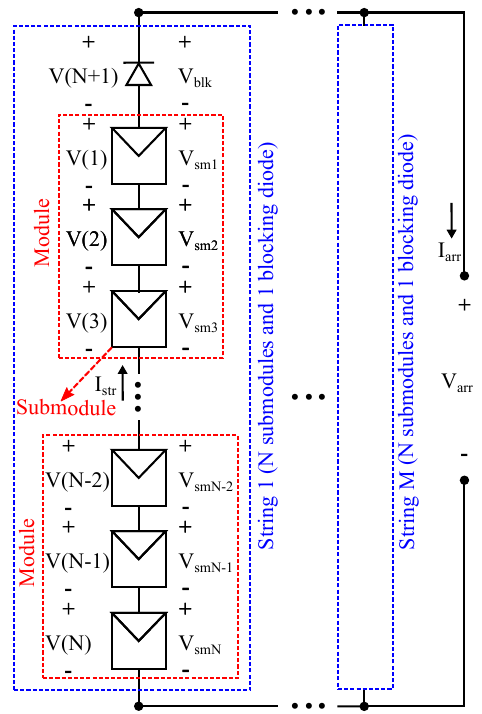
Figure 1. Structure of a Series-Parallel (SP) photovoltaic